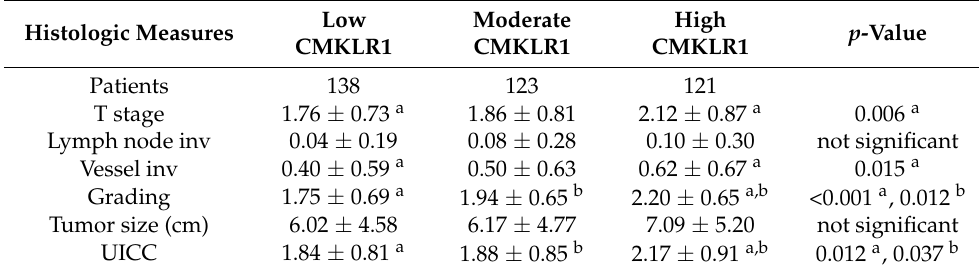
Table 4. T stage, lymph node invasion, vessel invasion, grading, tumor size, UICC stage, steatosis, inflammation, fibrosis stages, age, and chemerin scores of patients stratified for low, moderate, and high CMKLR1 protein in the tumors. a: comparison of tumors with low and high CMKLR1, b: comparison of tumors with moderate and high CMKLR1, and c: comparison of tumors with low and moderate CMKLR1 (inv,